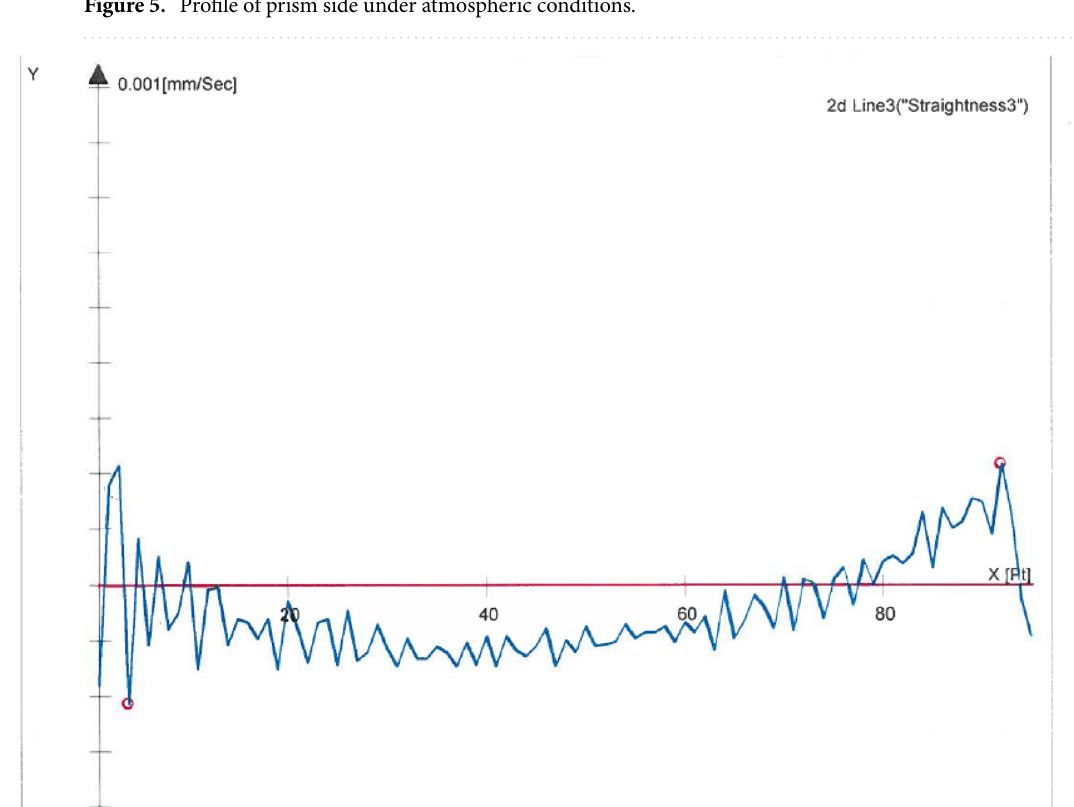
Figure 6. Profile of prism side under